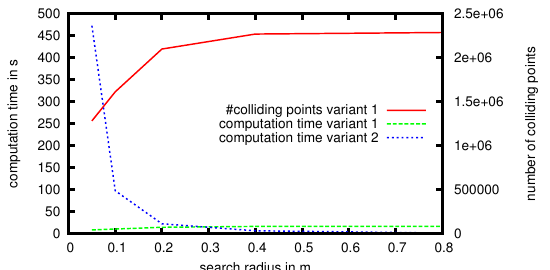
(d) Computation time of both penetration depth variants with dif- ferent search radii r . The distance between individual points on the trajectory d t and the distance between points in the model d m is chosen such that d t = d m = 2 were computed using the segmentation based collision detection